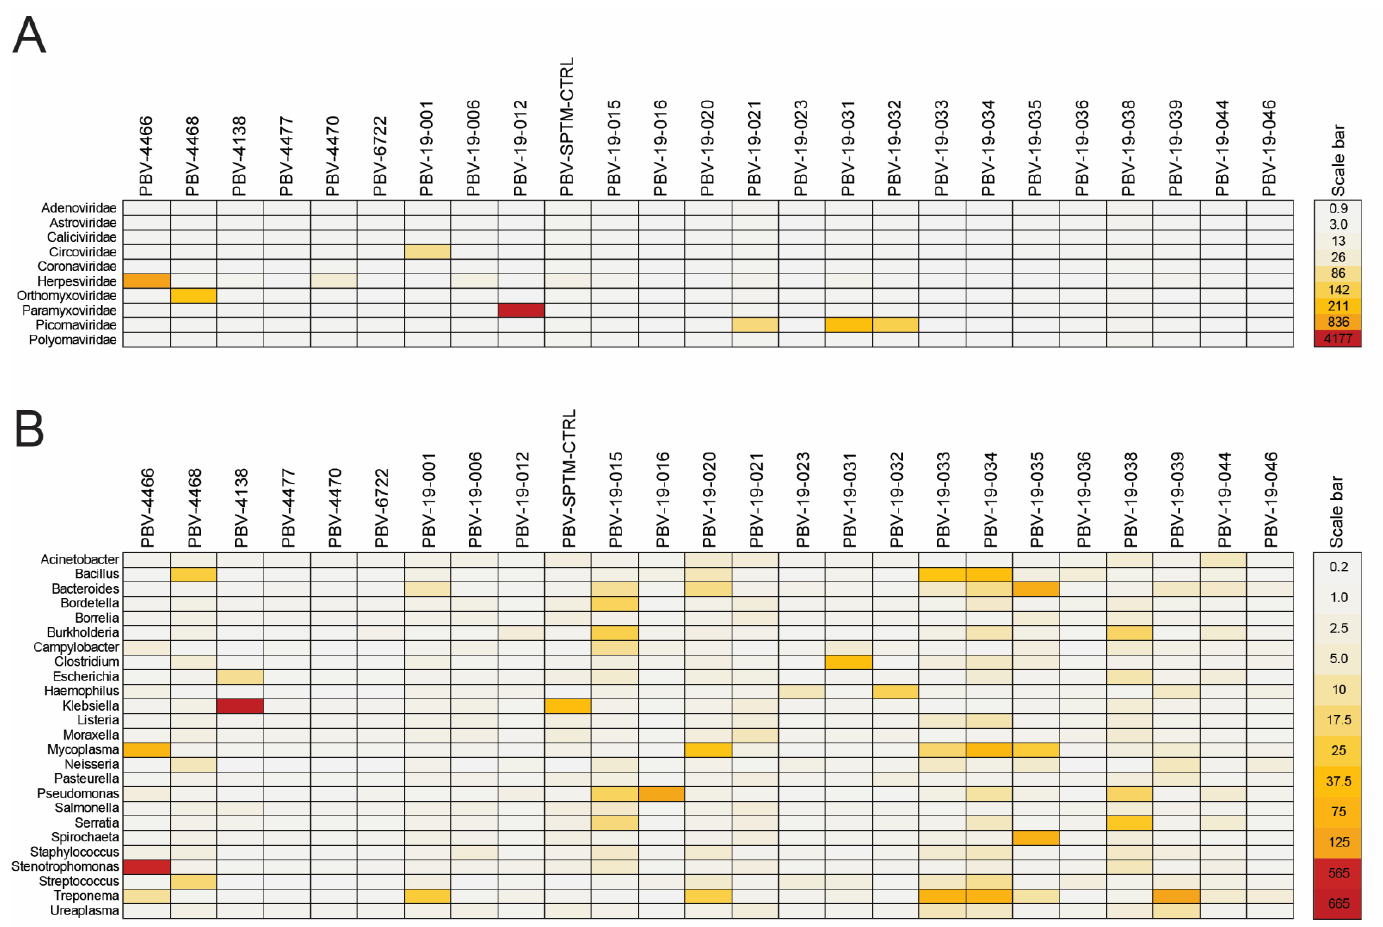
Figure 5. Co-infections are found in majority of PBV+ individuals. ( A ) Viral and ( B ) bacterial reads identified by SURPI from agents with known respiratory and gastrointestinal pathogenicity were sorted by family and genus, respectively. Read counts were normalized within samples, expressed as reads per million (RPM), and compared to other samples by calculating fold change relative to the median RPM number. Scale bars depict the magnitude fold change for each heat map. A 100 (absolute) read cutoff was established for bacteria, resulting in no comparisons for Legionella spp., Chlamydia pneumonia , and Mycobacterium tuberculosis .